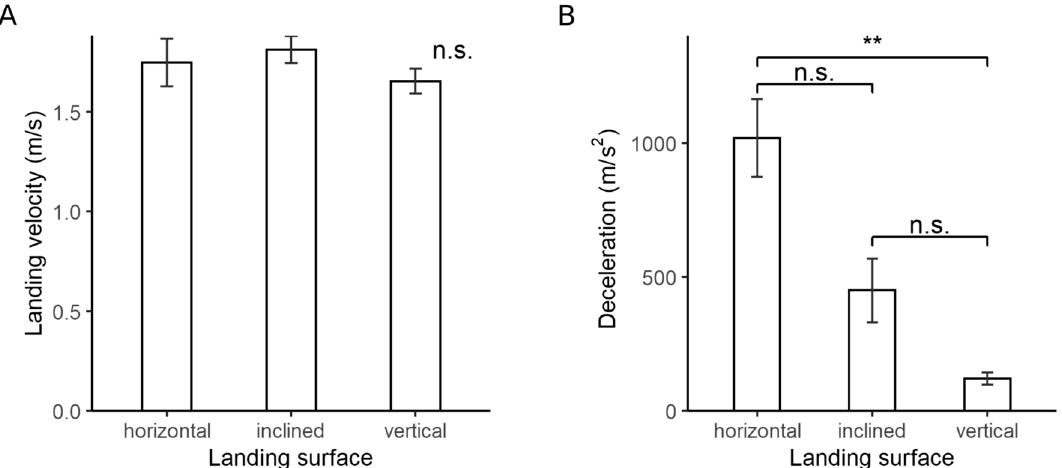
Figure 8. Landing kinematics. ( A ) Velocity of the belly perpendicular to the landing platform at the moment of first contact with the surface. ( B ) Maximum deceleration of the belly during landing. Bar plots show mean values and standard errors. n.s.: no significance; **: 0.01 < p < 0.001; ***: p <